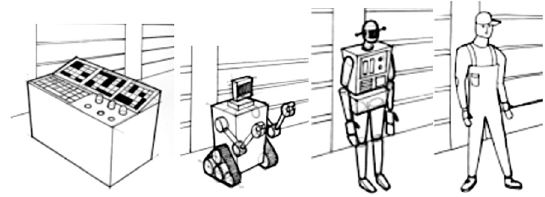
Figure 1: The four linesmen from Malle et al. that we transport to our video clips ( left to right ) : AI, mechanical, humanoid, and